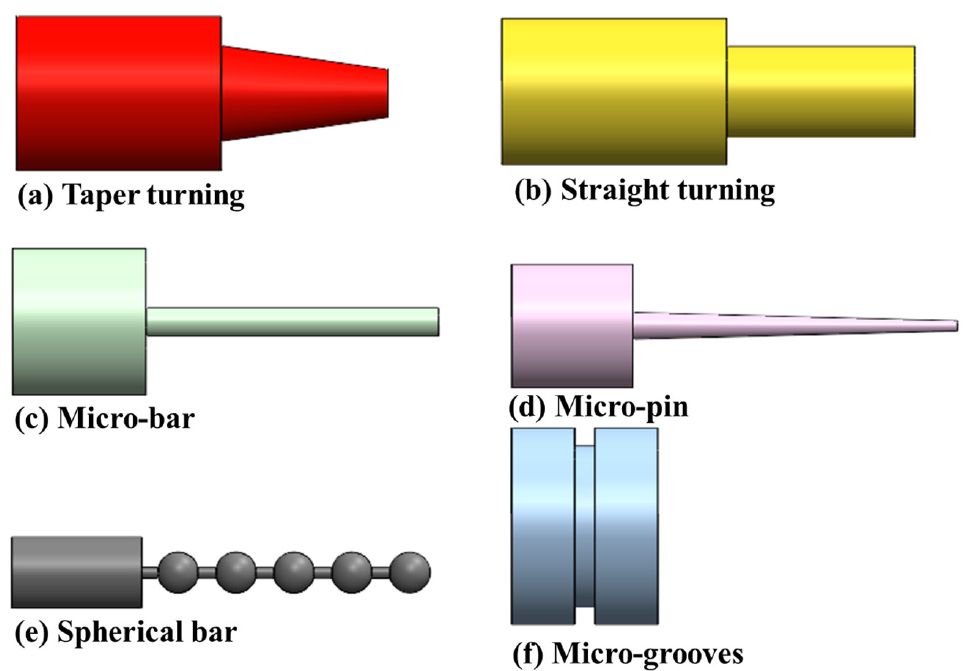
Figure 1. Schematic representation of turning process types and range of parts made by them: ( a ) Taper turning; and ( b ) Straight turning; ( c ) high-aspect-ratio micro-bar; ( d ) high-aspect-ratio micro-pin; ( e ) spherical bar; and ( f ) micro-grooves.